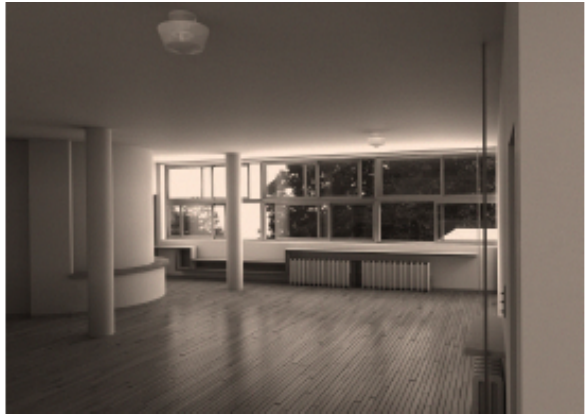
Figure 16. Rendering of one of the room in the original design